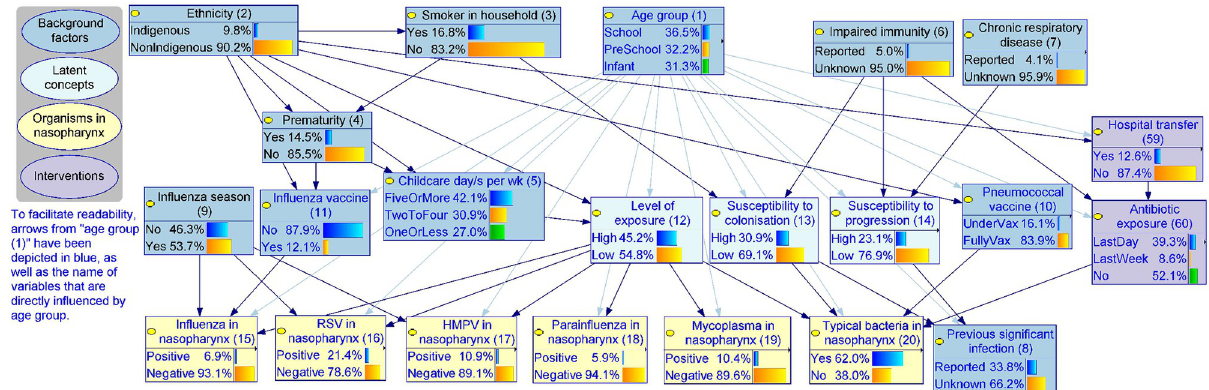
Fig 4. The epidemiological context, BN v4.5. Due to the number of arcs emanating from Age group, a lighter shade of blue has been used to make the graph easier to read. The detailed model structure and definition for each variable are provided in S1 Table. Source model files can be accessed via Open Science Framework